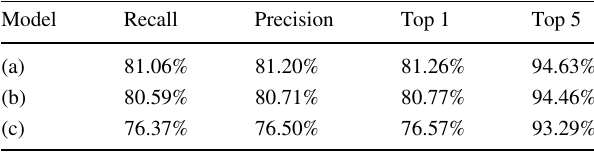
Table 1 The accuracy of three models for ImageNet100